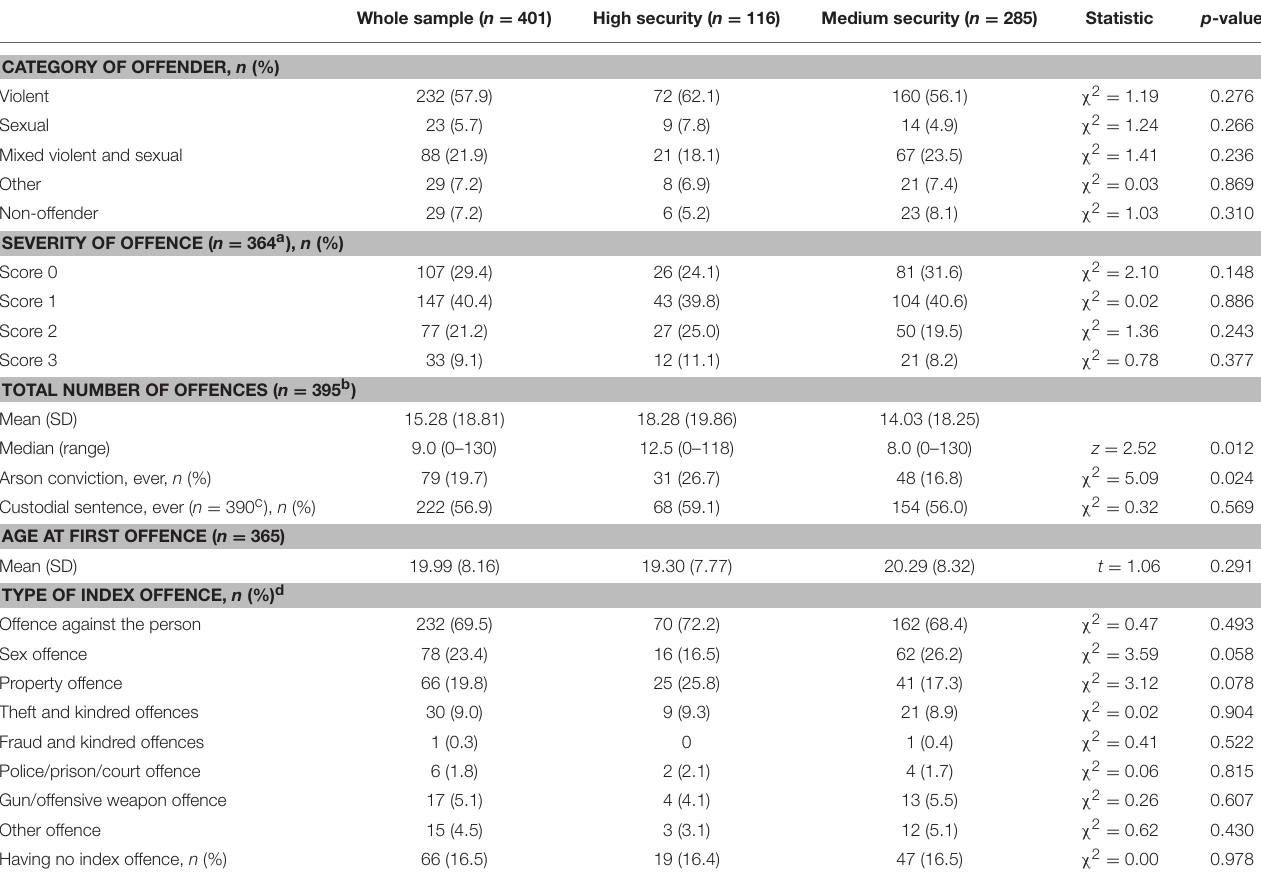
TABLE 4 | Offending history of long-stay forensic